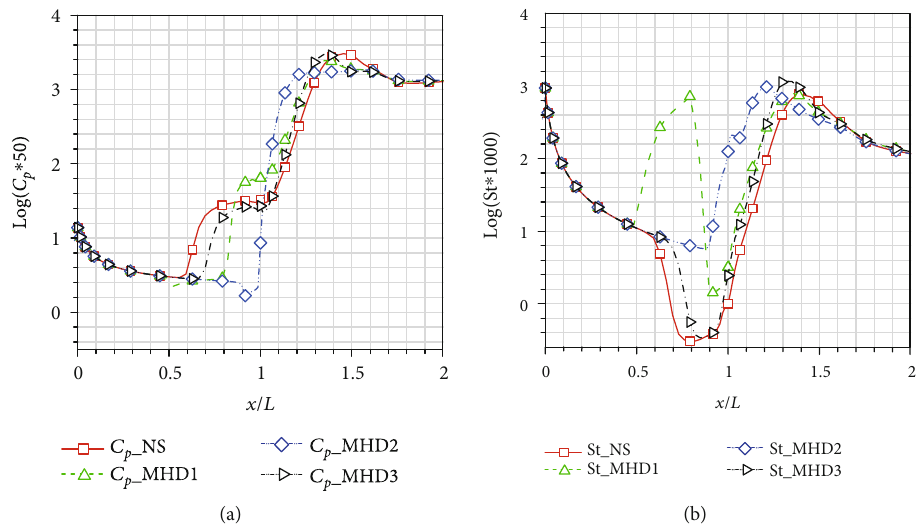
Figure 12: E ff ect of the interaction region location on the wall pressure and wall heat transfer distribution: (a) wall pressure distribution; (b) wall heat transfer